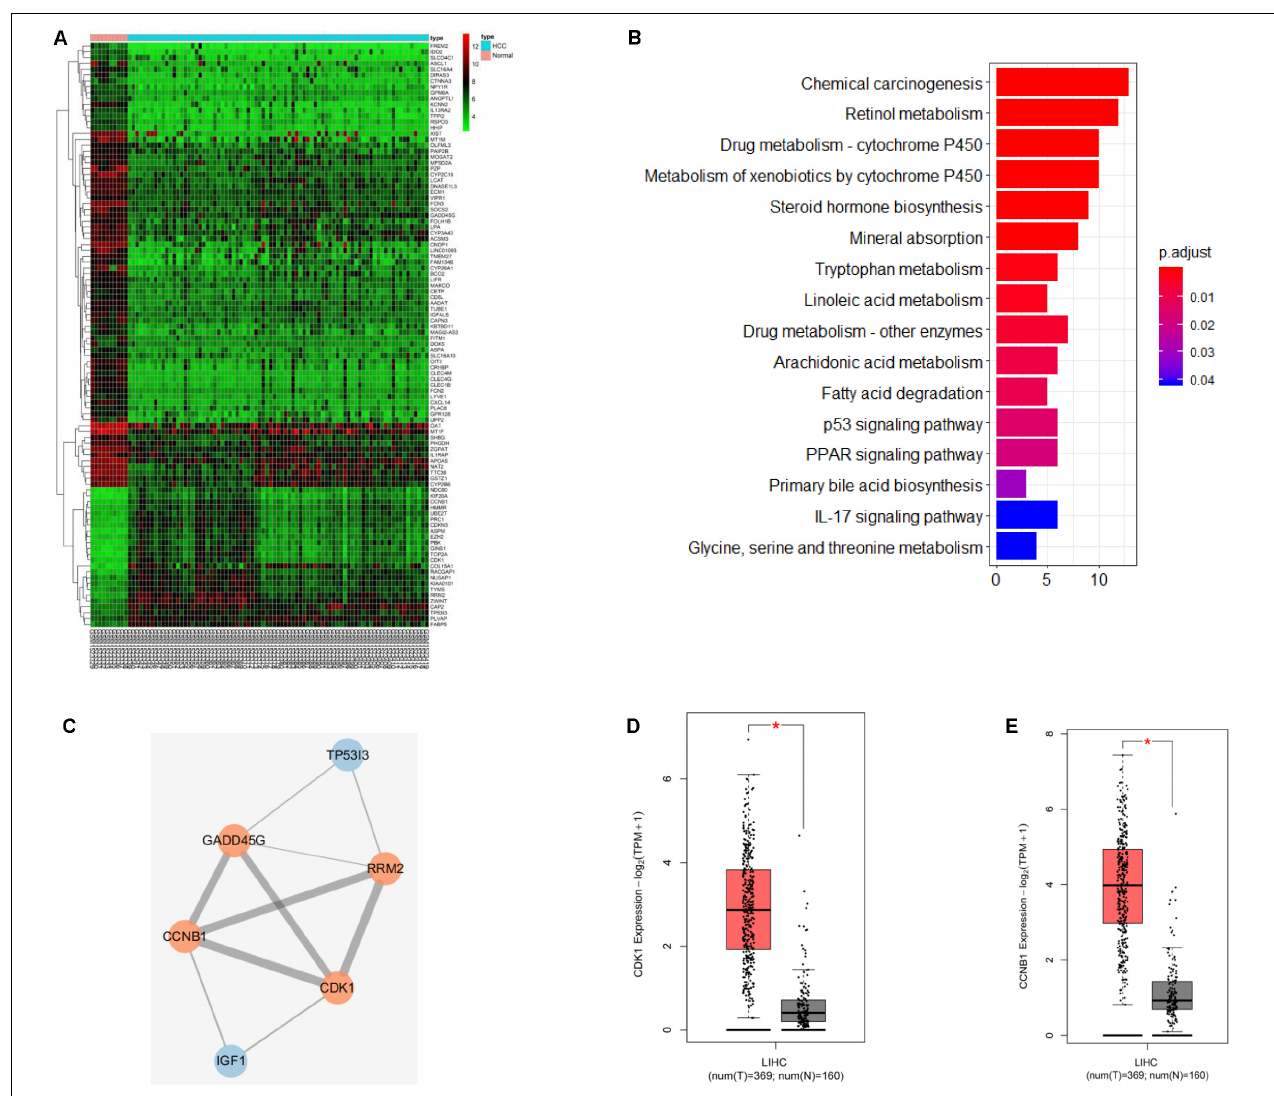
FIGURE 1 | CDK1 and CCNB1 are possible targets for HCC. (A) Heat map of the first 100 DEGs expression in GSE62232 dataset from GEO database; (B) KEGG pathway enrichment analysis of DEGs in GSE62232 dataset; (C) Interaction analysis of DEGs in p53 signaling pathway, orange represents high expression and blue represents low expression; (D,E) CDK1 and CCNB1 gene expression in HCC samples and normal samples from TCGA database, red is the tumor sample and black is the normal sample. *represents P <